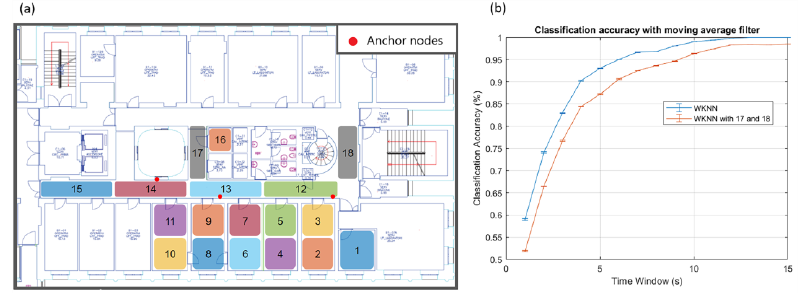
Figure 11. Test site map. The two additional areas (17 and 18) are gray ( a ). Drop-in performances are determined by the presence of the new regions ( b ).